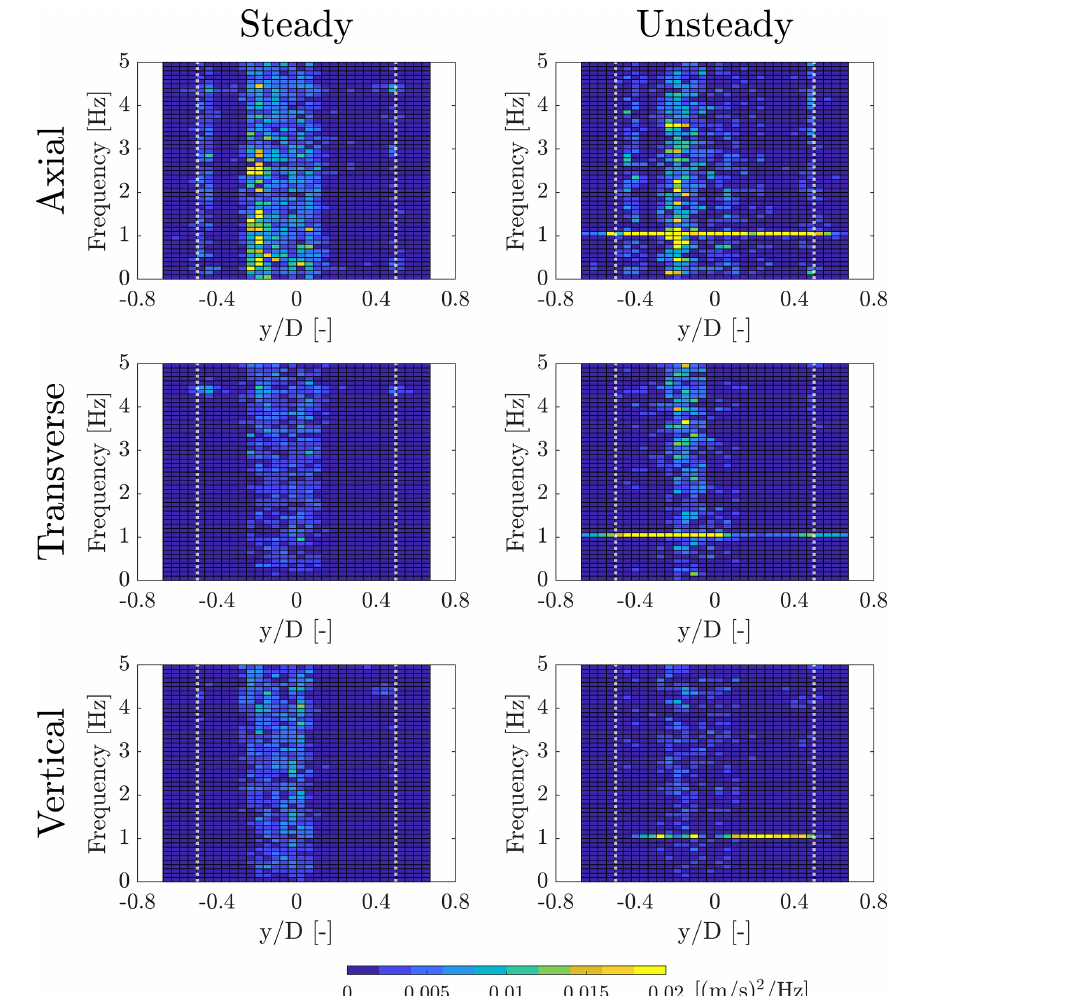
Figure 11. PSD of the hub-height wake velocity components in several cross-wind positions ( y/D = 0 corresponds to the hub location, and rotor edge is marked by the vertical dotted lines) for the ABOVE case. The surge motion of the unsteady case is with f s = 1Hz and A s = 0 .